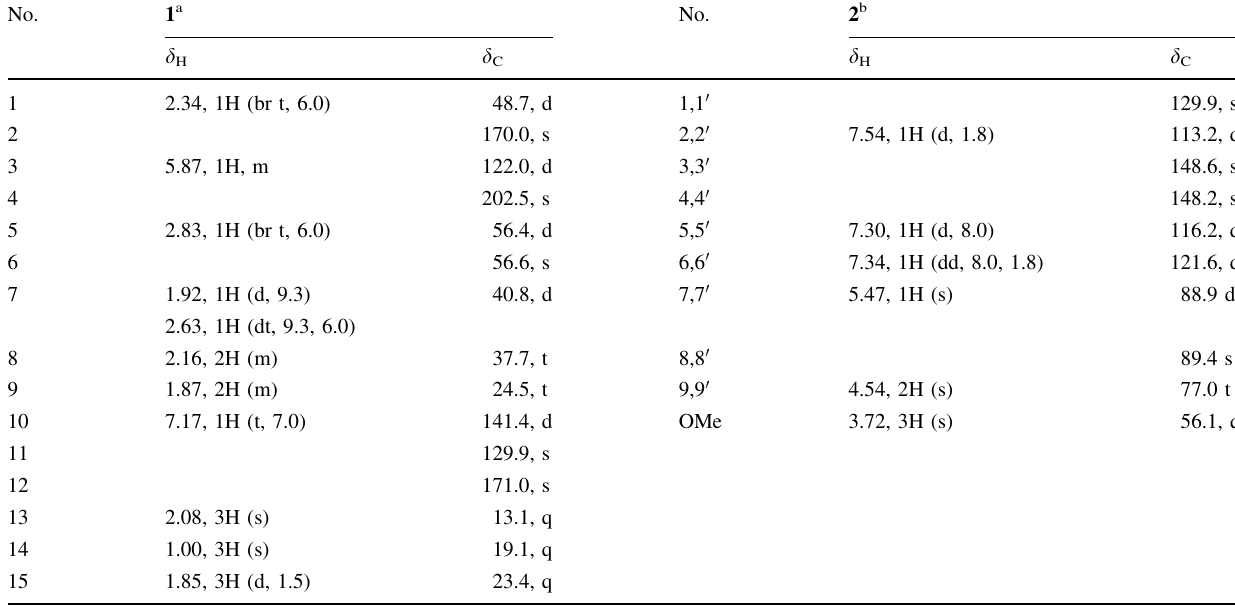
Table 1 NMR data of 1 and 2 (C 5 D 5 N, d in ppm, J in Hz)